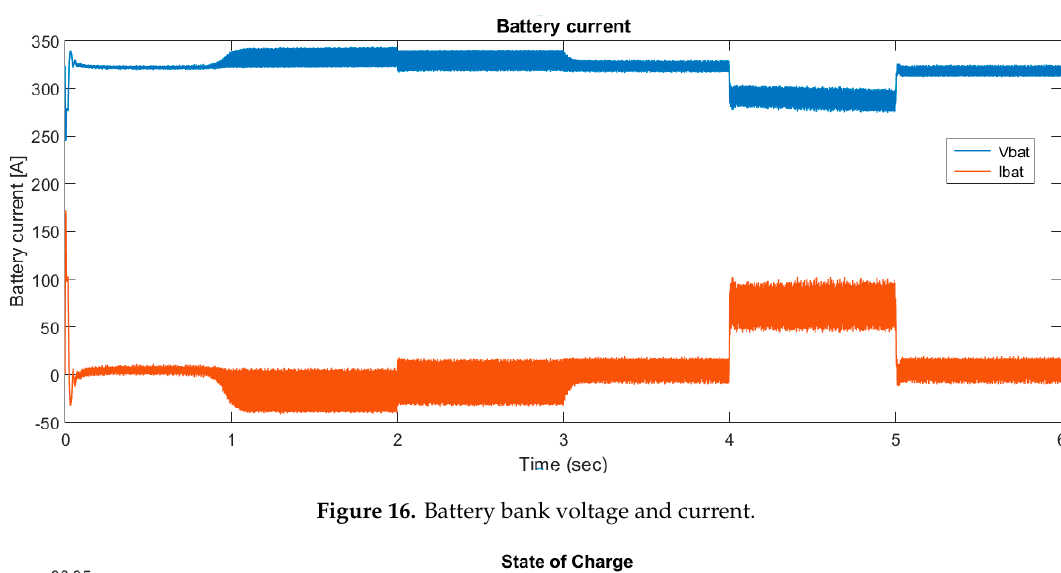
Figure 15. PV panels output voltage and current.